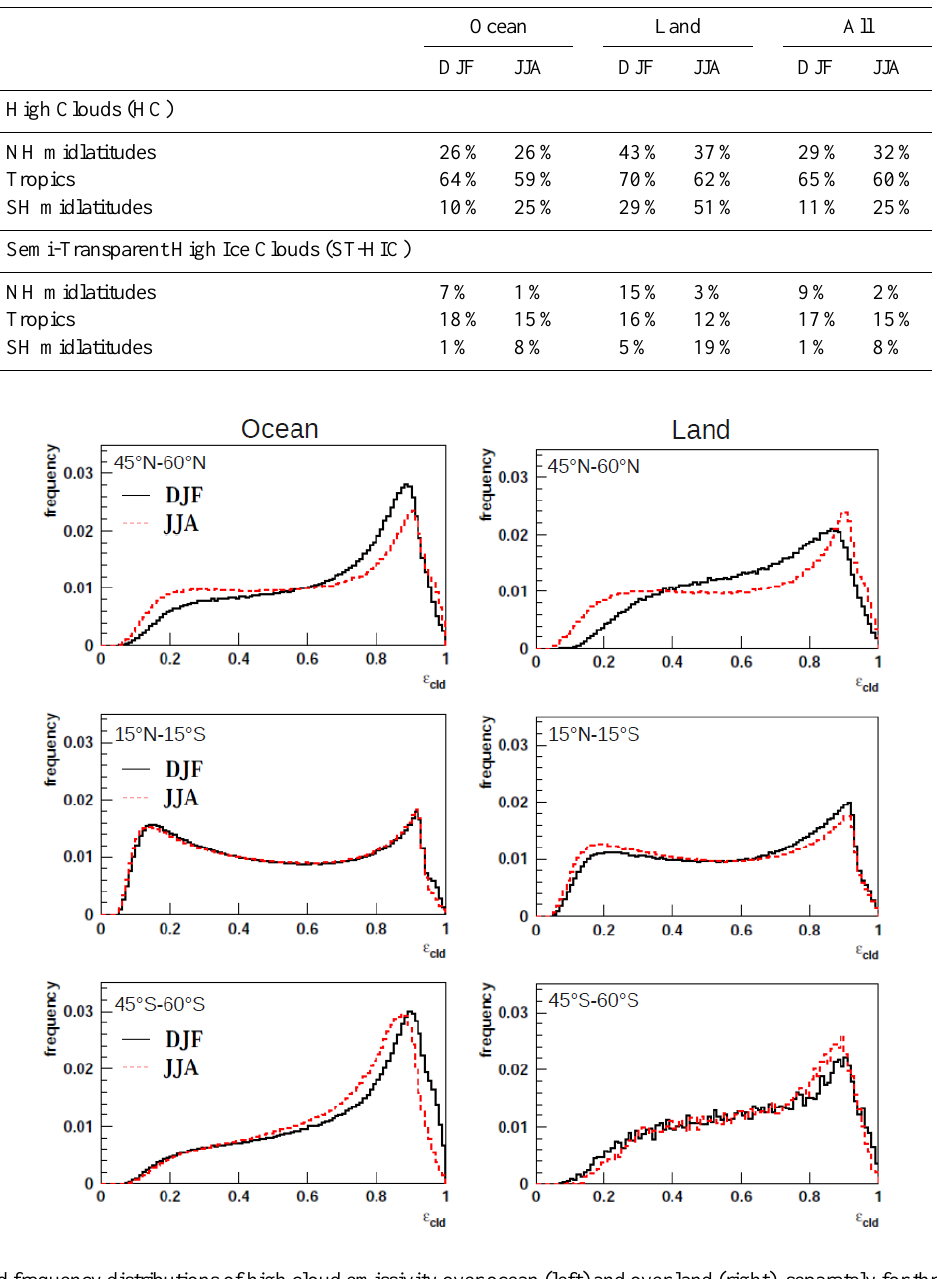
Table 3. Amount of high clouds (HC) and semi-transparent high ice clouds (ST-HIC) relative to total cloud amount, averaged over the period 2003–2009 in three latitude bands (NH: 45 ◦ N–60 ◦ N, Trop: 15 ◦ N–15 ◦ S, SH: 45 ◦ S–60 ◦ S), for boreal winter and boreal summer and over different surfaces (ocean, land and all surfaces).